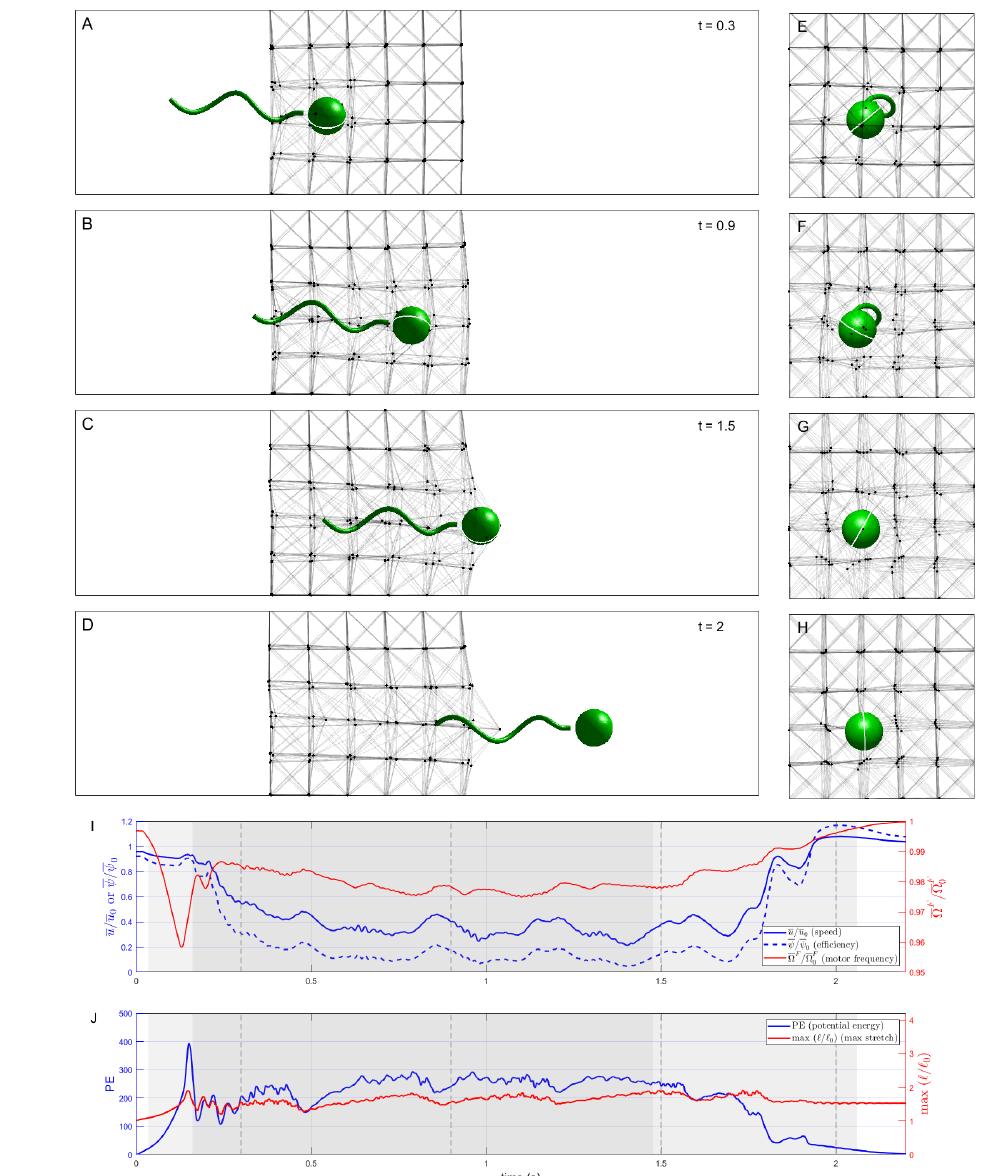
Figure 4. Summary of results for E = 25 mPa, η = 10 mPa-s. See Figure 3 for panel descriptions. See in Supplementary Materials Video S2 for an animated